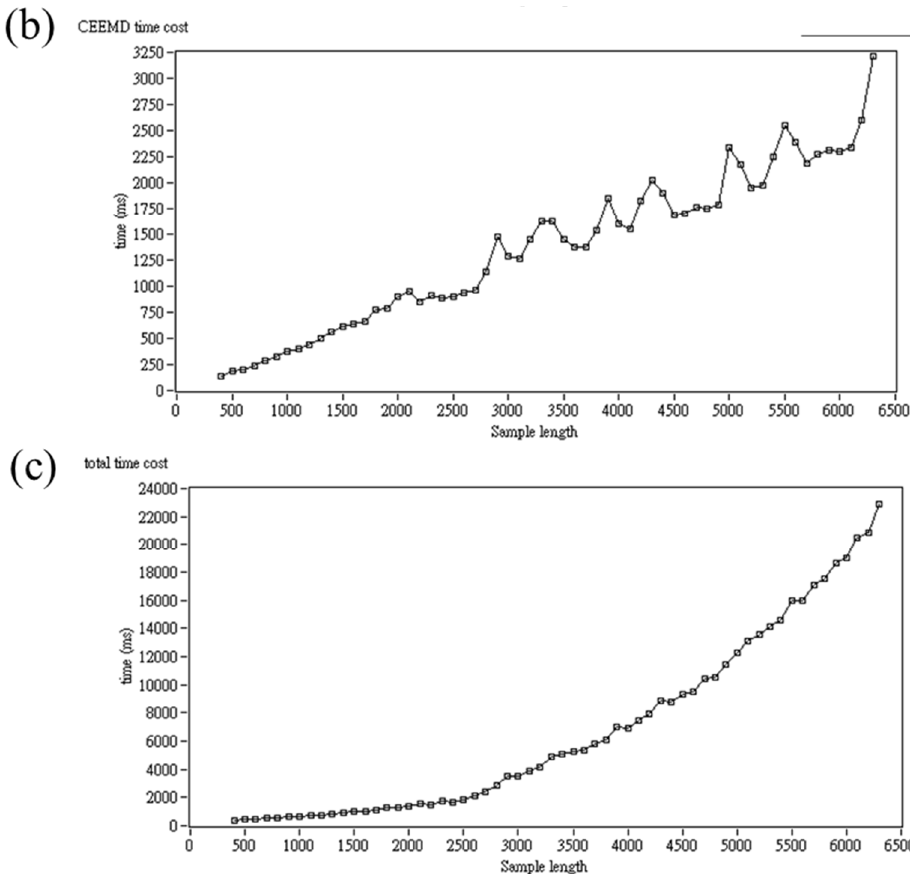
Figure 8. Computing time cost of ( a ) SampEn; ( b ) CEEMD; ( c ) total time cost.